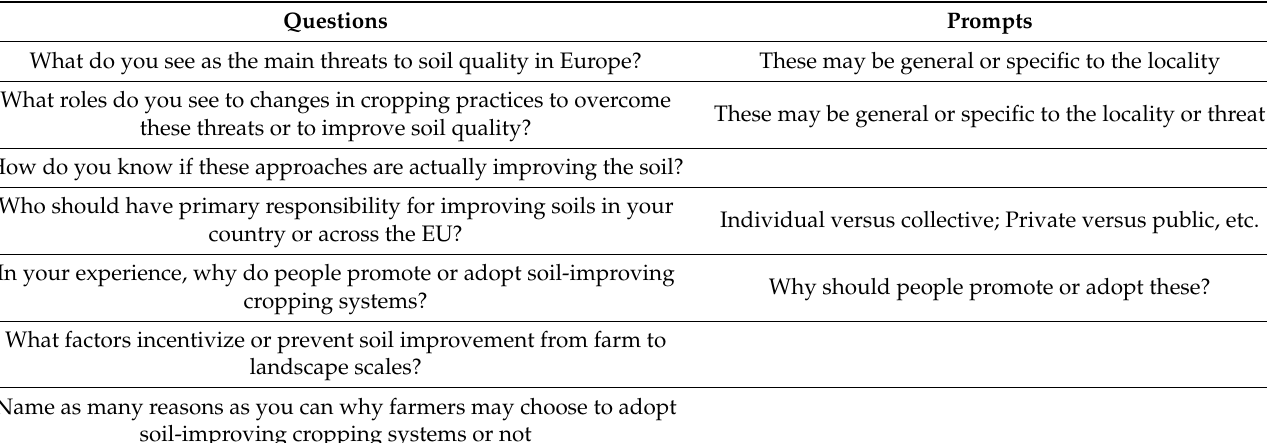
Table 1. Interview guide used to develop the